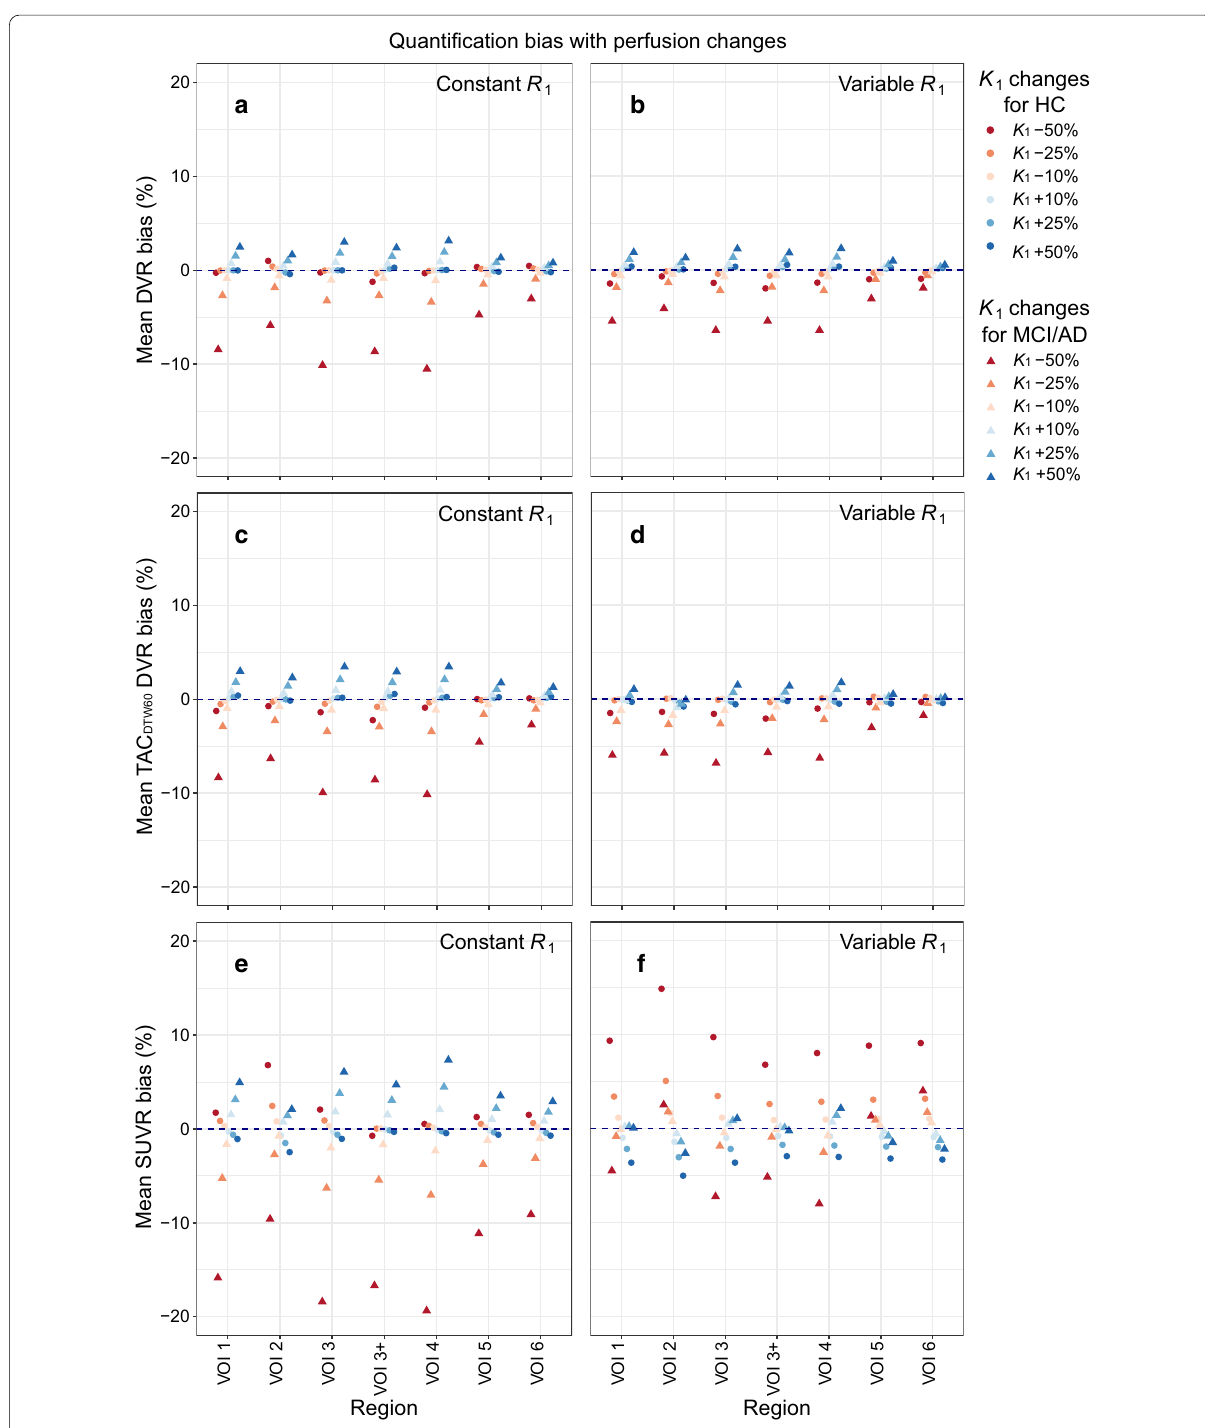
Fig. 1 Average quantification bias due to perfusion changes. Changes with constant R 1 are shown on the left, and with variable R 1 on the right. Subject diagnosis is shown by data point shape and tracer influx rate ( K 1 ) changes by color. a , b show the bias for Reference Logan DVR on the uninterrupted TAC (TAC 120 ), c , d show the bias for Reference Logan DVR on the dual-time-window TAC with 60-min break (TAC DTW60 ), and e , f show the bias for